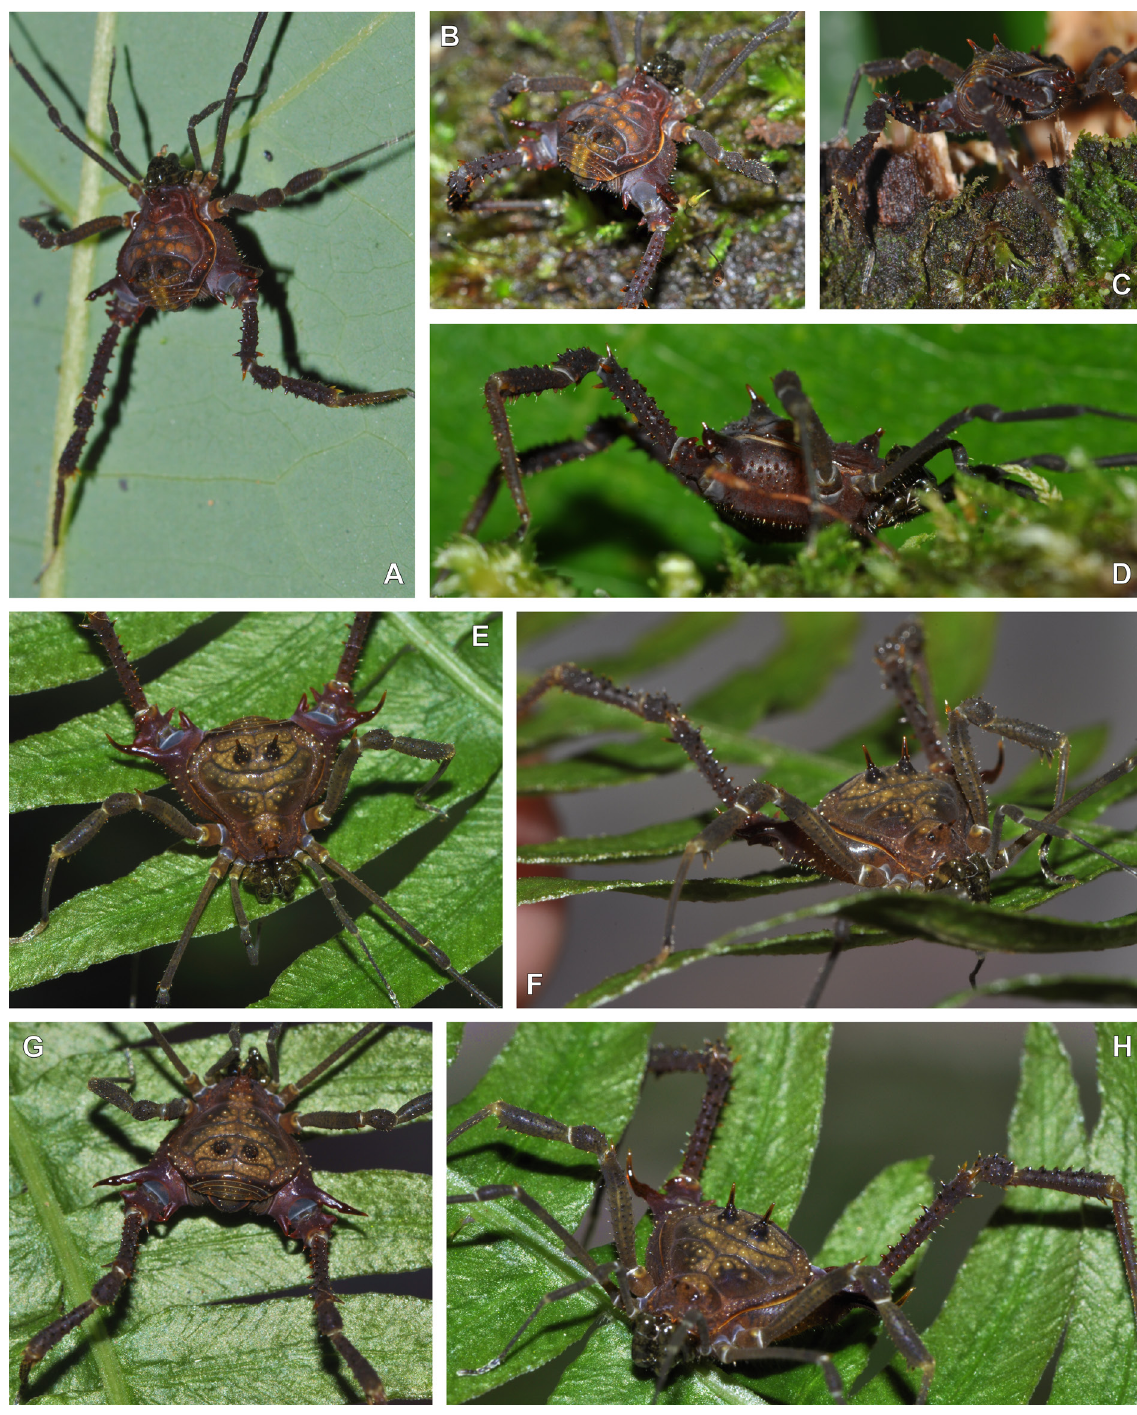
Fig. 3. Lacronia spp., specimens in vivo. A–D . L. nigra (B. Soares, 1942) comb. nov., ♂, from